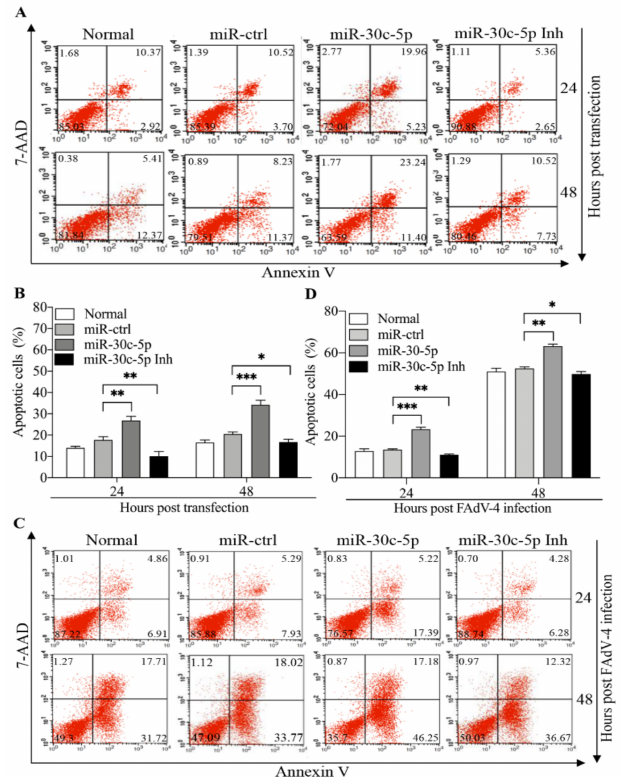
Figure 2. Transfection of LMH cells with gga-miR-30c-5p induces apoptosis and enhances FAdV-4- induced apoptosis. ( A ) The LMH cells were seeded on 12-well plates and cultured overnight, followed by transfection with gga-miR-30c-5p mimics, inhibitors (Inh), or miRNA controls. At different time points (24 and 48 h) post-transfection, cells were harvested, stained with Annexin V-PE and 7-AAD, and examined for apoptosis by flow cytometry. ( B ) The percentage of apoptotic cells in each group shown in panel A was graphed and statistically analyzed. ( C ) The LMH cells were seeded on 12-well plates and cultured overnight, followed by transfection with gga-miR-30c-5p mimics, gga-miR-30c-5p inhibitors or miRNA controls. Twenty-four hours after transfection, cells were infected with FAdV-4 at an MOI of 1. At different time points (24 and 48 h) post-FAdV-4 infection, the cells were examined for apoptosis by flow cytometry as described above. ( D ) The percentage of apoptotic cells in each group shown in panel ( C ) was graphed and statistically analyzed. Data are representative of three independent experiments and presented as means ± SD. (*** stands for p < 0.001; ** for p < 0.01; * for p <